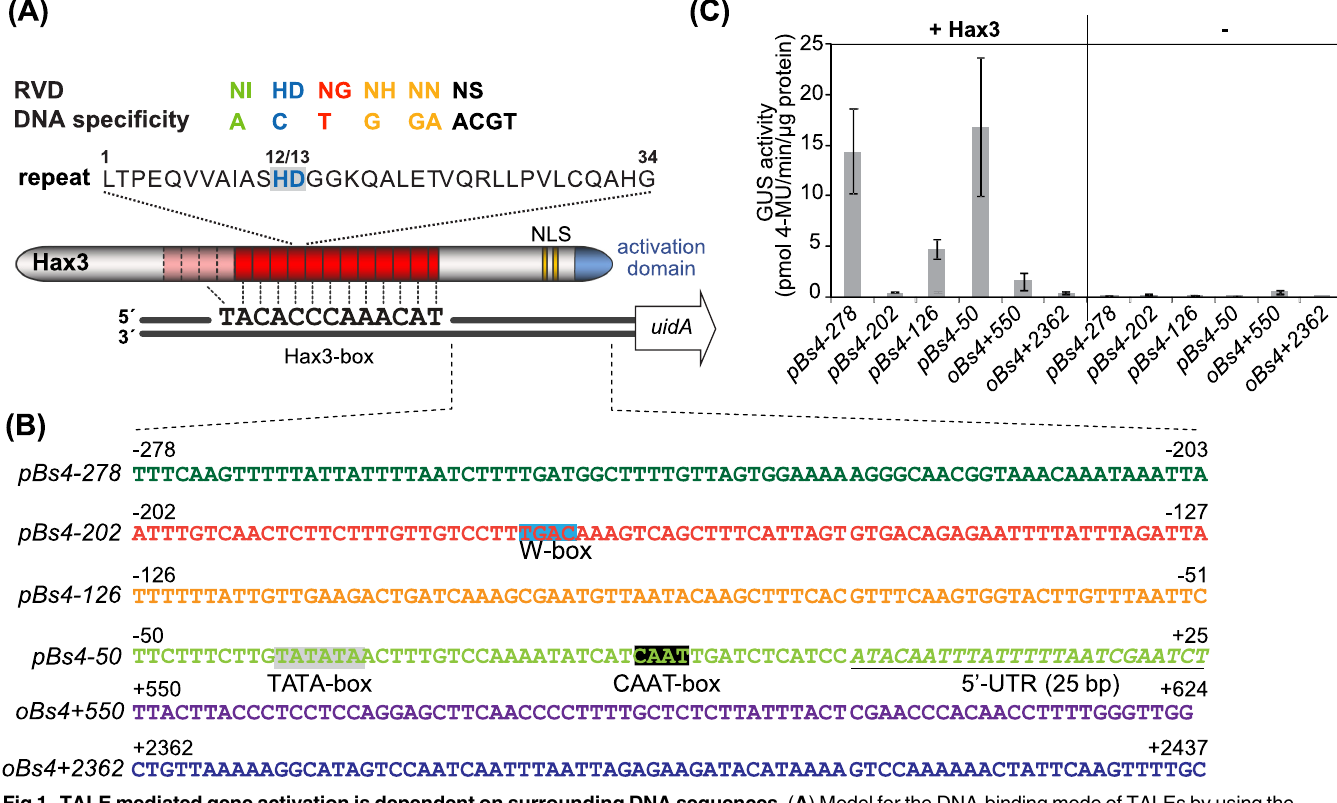
Fig 1. TALE mediated gene activation is dependent on surrounding DNA sequences. ( A ) Model for the DNA-binding mode of TALEs by using the exampleof Hax3 alignedto the Hax3-box. TALEs contain a central repeat region (red), two nuclear localization signals(NLS) and an acidic activationdomain in the C-terminal part. The amino acid sequenceof a Hax3 repeat is shown in single letter code. The repeat variable diresidue(RVD) is shaded in grey. Each RVD specifies one nucleotidein the DNA-target sequence.( B ) Sequenceoverviewof the analysed75 bp long DNA fragments that originateeither from the Bs4 promoter( pBs4 , regionfrom -278 bp to +25 bp) or from the Bs4 open readingframe ( oBs4 ). Potential promoter elementsthat were predicted [37] are labelledin grey (TATA-box) blue (W-box), black (CAAT-box) or italic and underlined(5’ untranslated region, UTR). ( C ) TALE-dependentactivationof reporter constructs. Each promoterfragment was placeddownstreamof the Hax3-boxand insertedin front of a promoterless uidA reporter gene. Agrobacterium strains delivering hax3 under control of the 35S promoter were co-inoculated into N . benthamiana leaves along with an Agrobacterium strain deliveringthe respectivereporter construct. As negative control, all reporter constructs were inoculatedwith an empty vector construct (-). The quantitative β - glucuronidase measurement was performed 2 dpi, error bars were calculatedon the basis of three independent replicates and represent the standard deviation. (4-MU,